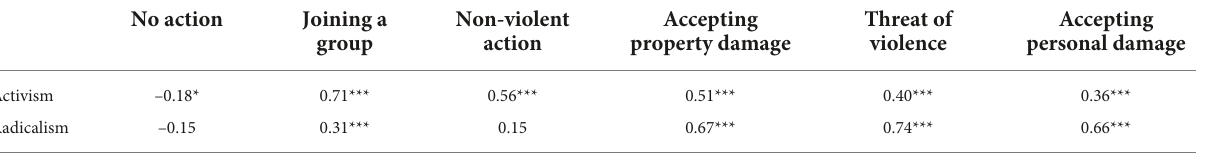
TABLE 1 Correlations among activism and radicalism items.